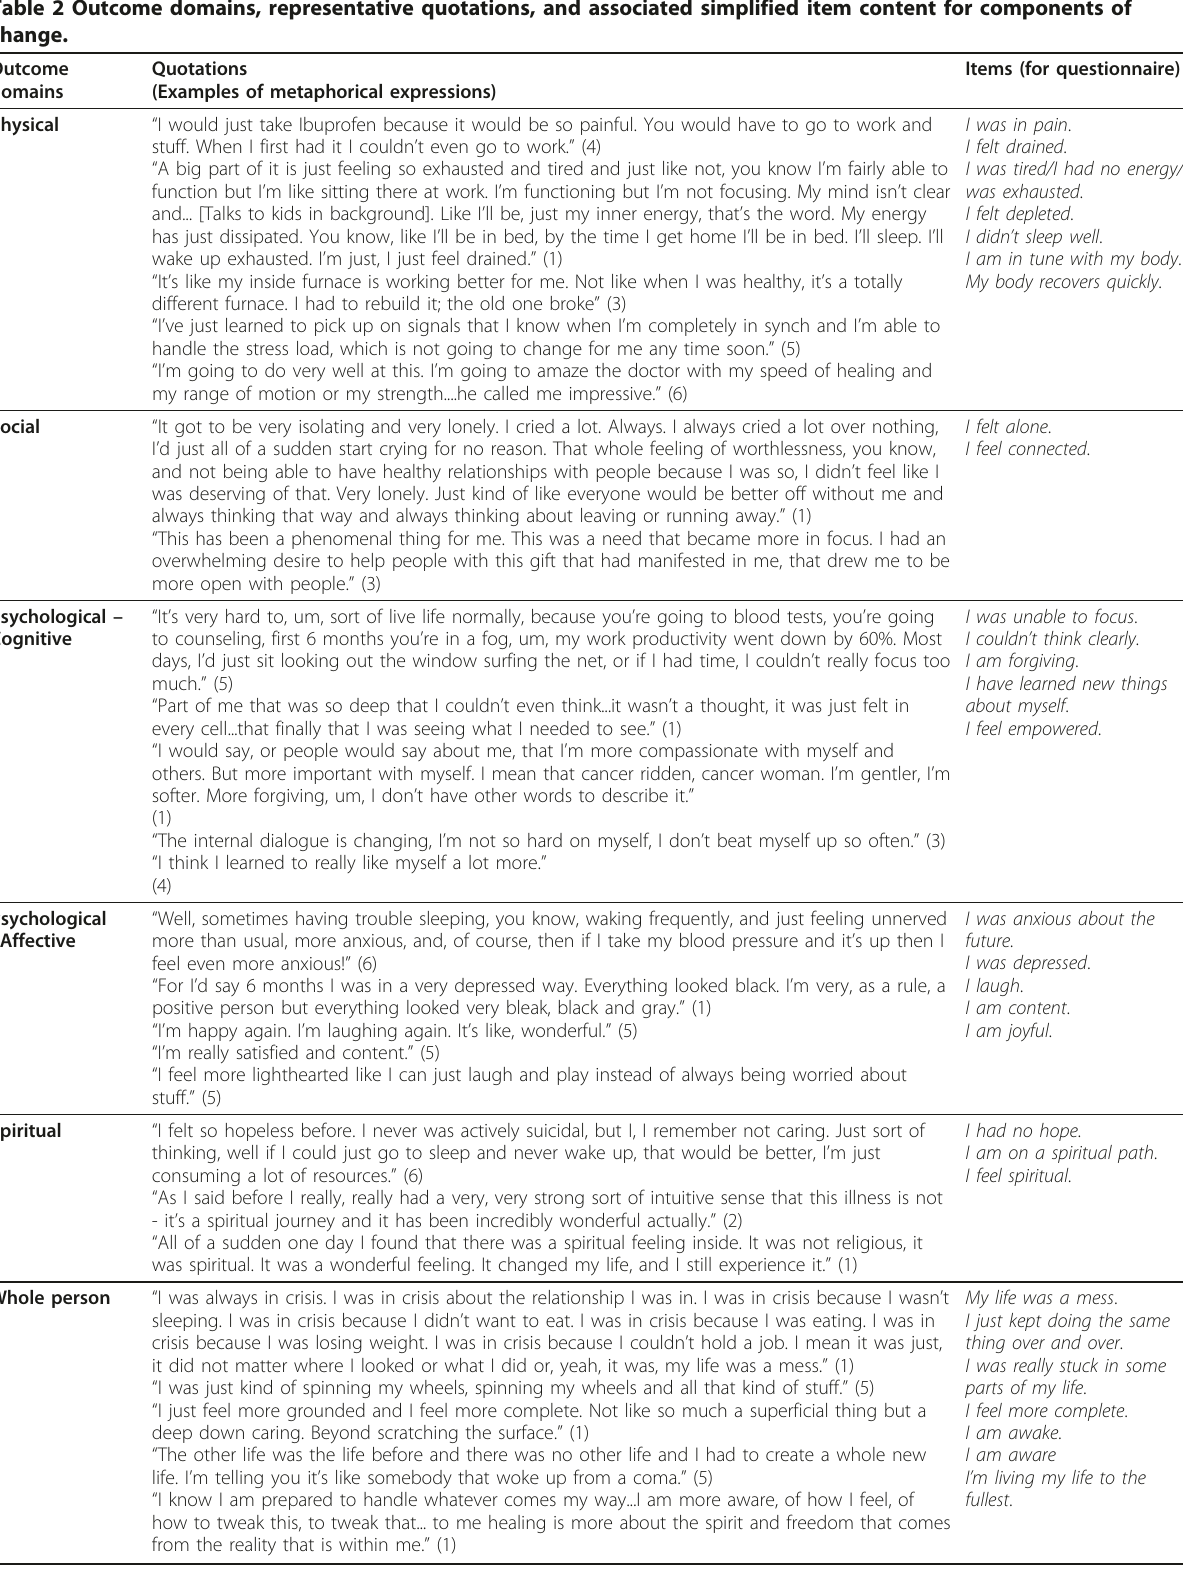
Table 2 Outcome domains, representative quotations, and associated simplified item content for components of